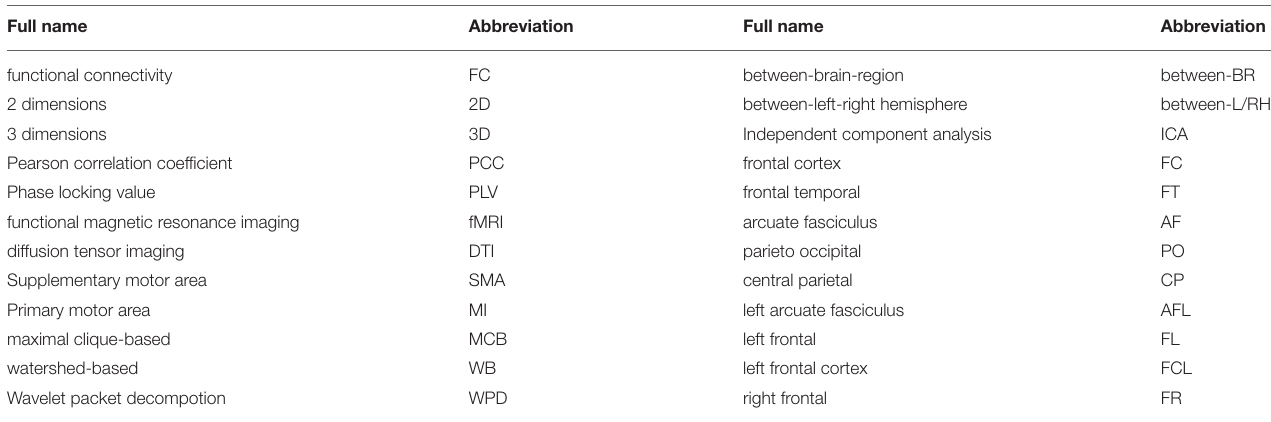
TABLE 4 | Full name and